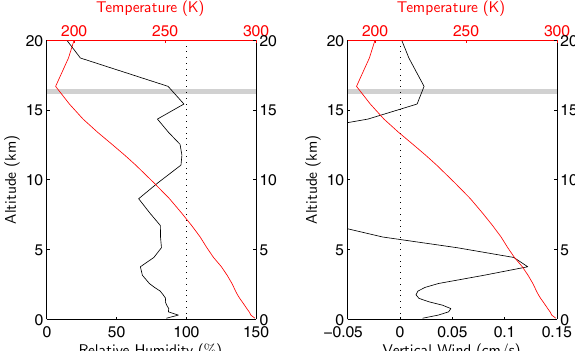
Fig. 6: ECMWF temperature, relative humidity, and vertical wind profiles for OSIRIS scan 49644019.